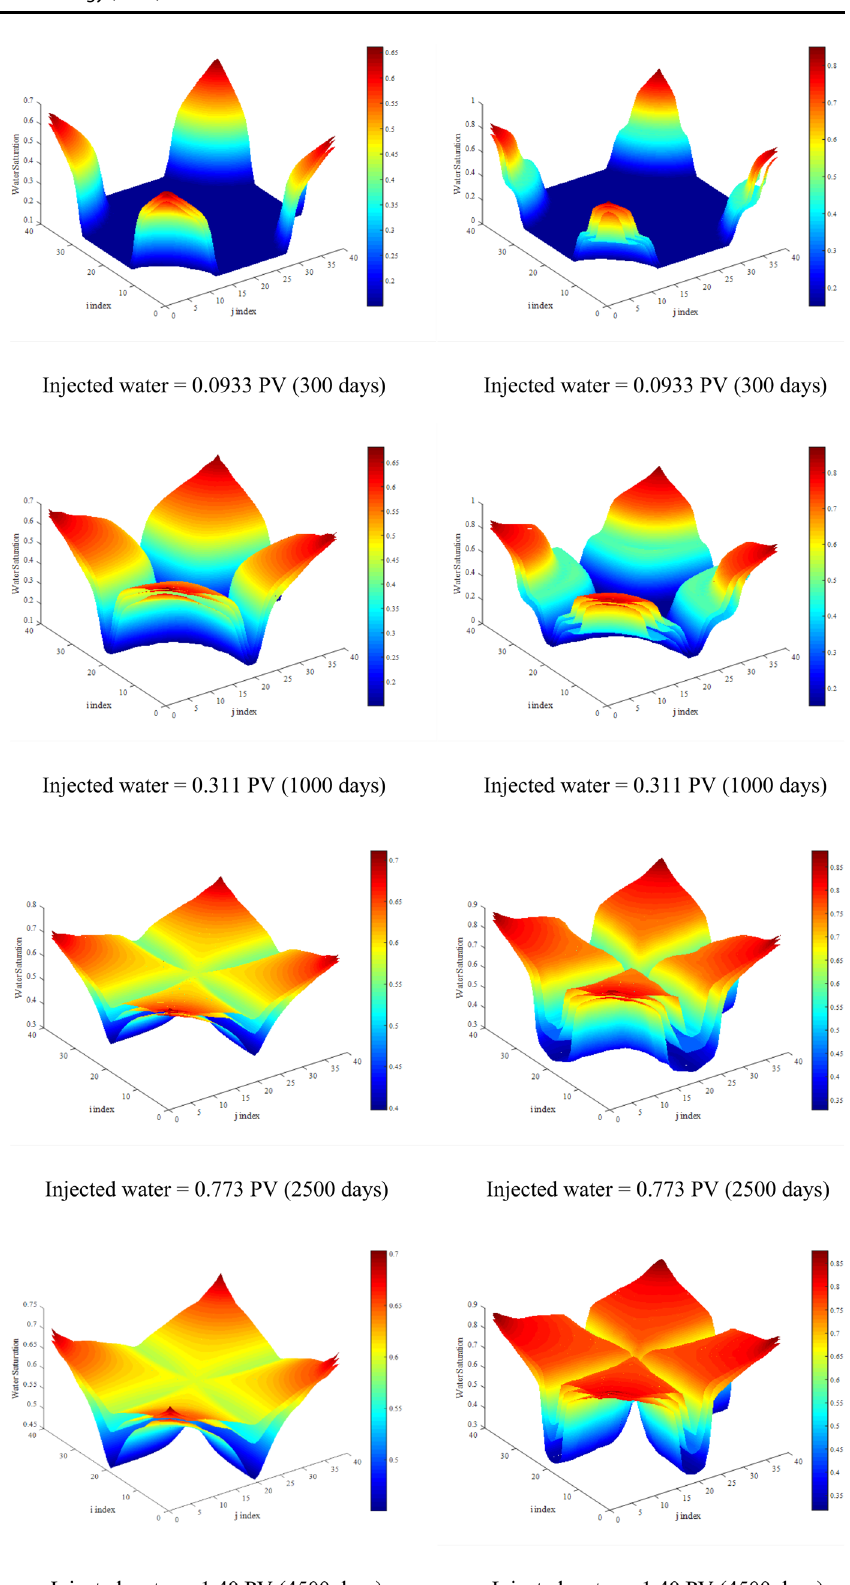
Fig. 9 Water saturation distribu- tion for HSW flooding (left side) and model#2 (right